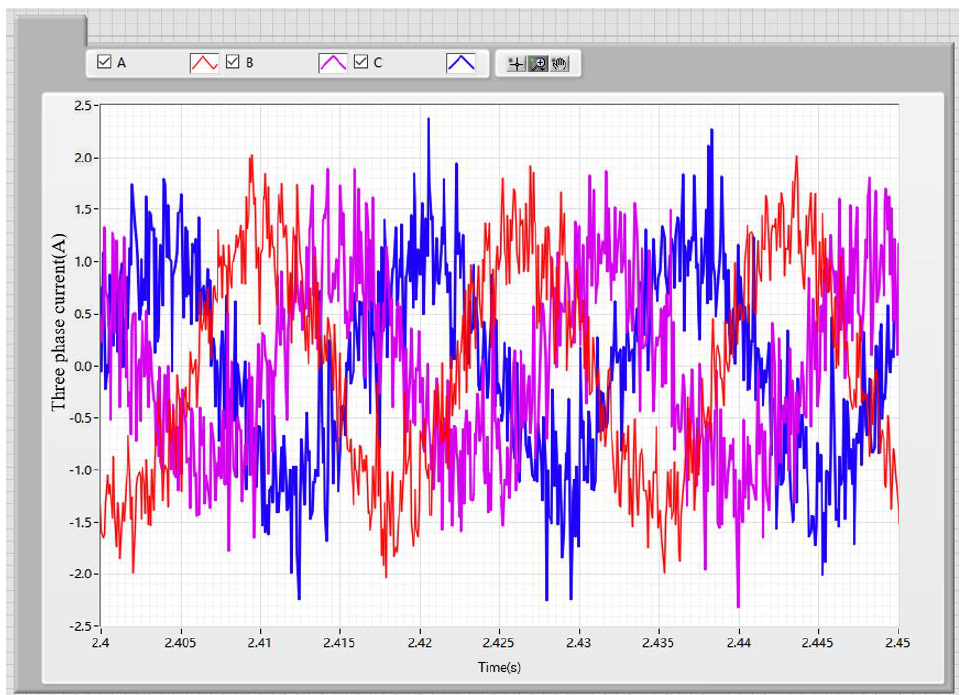
Figure 14. Sampling waveform of a motor three − phase current in a mild turn − to − turn short circuit state.